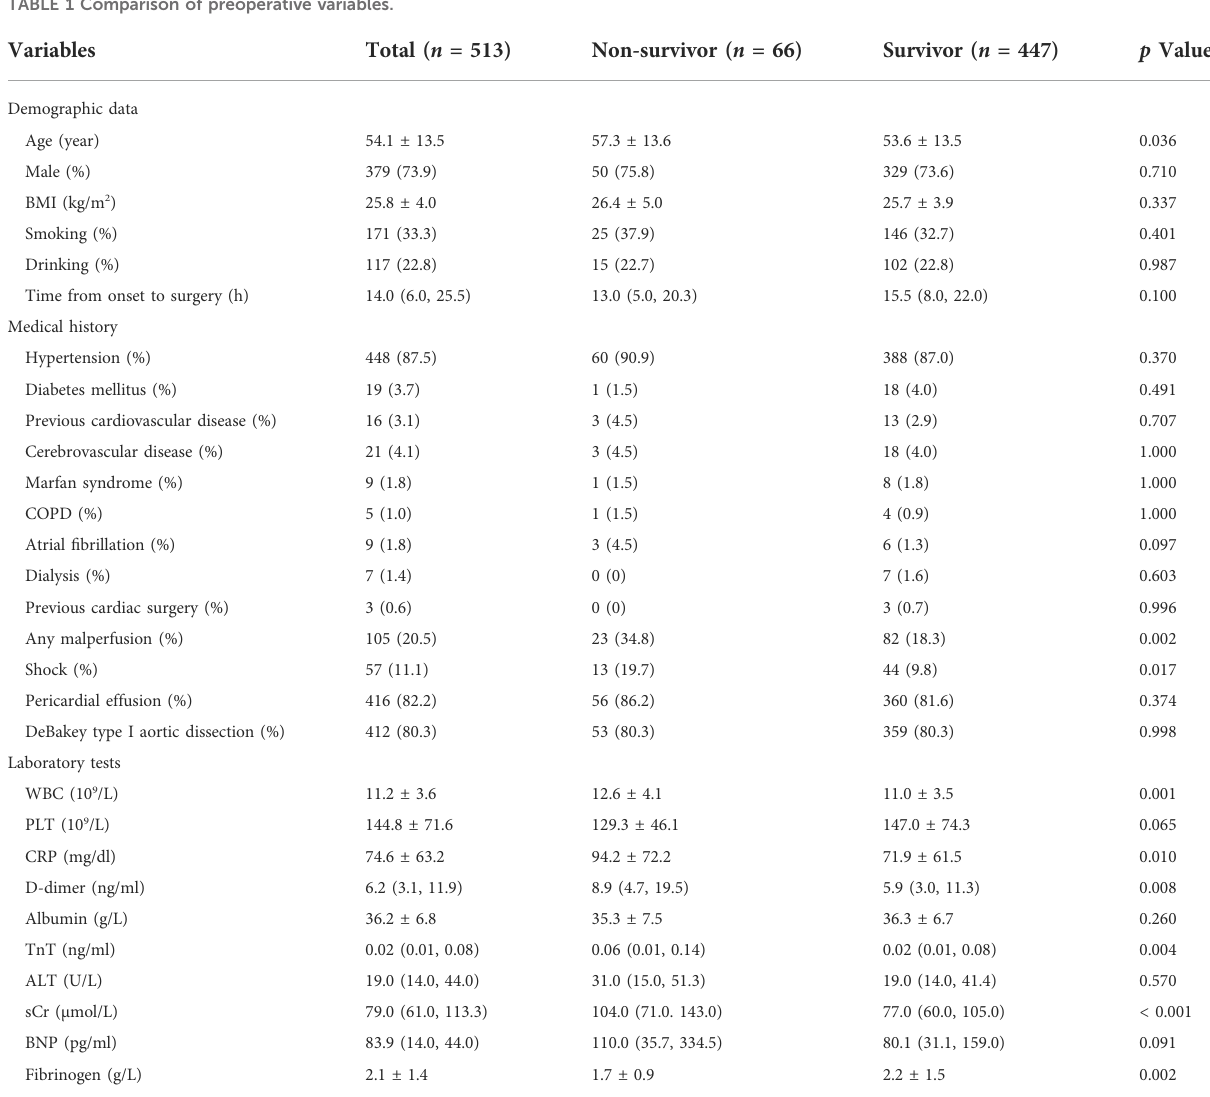
TABLE 1 Comparison of preoperative